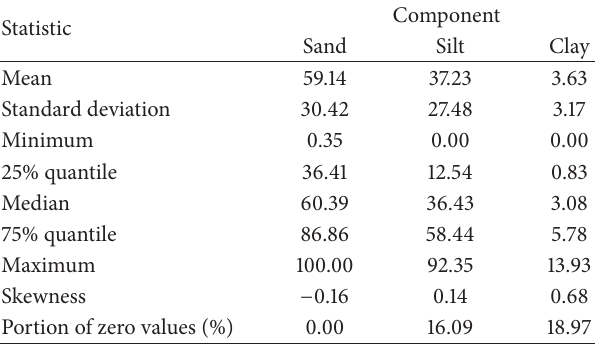
Table 1: Summary statistics of grain size fractions in all samples.